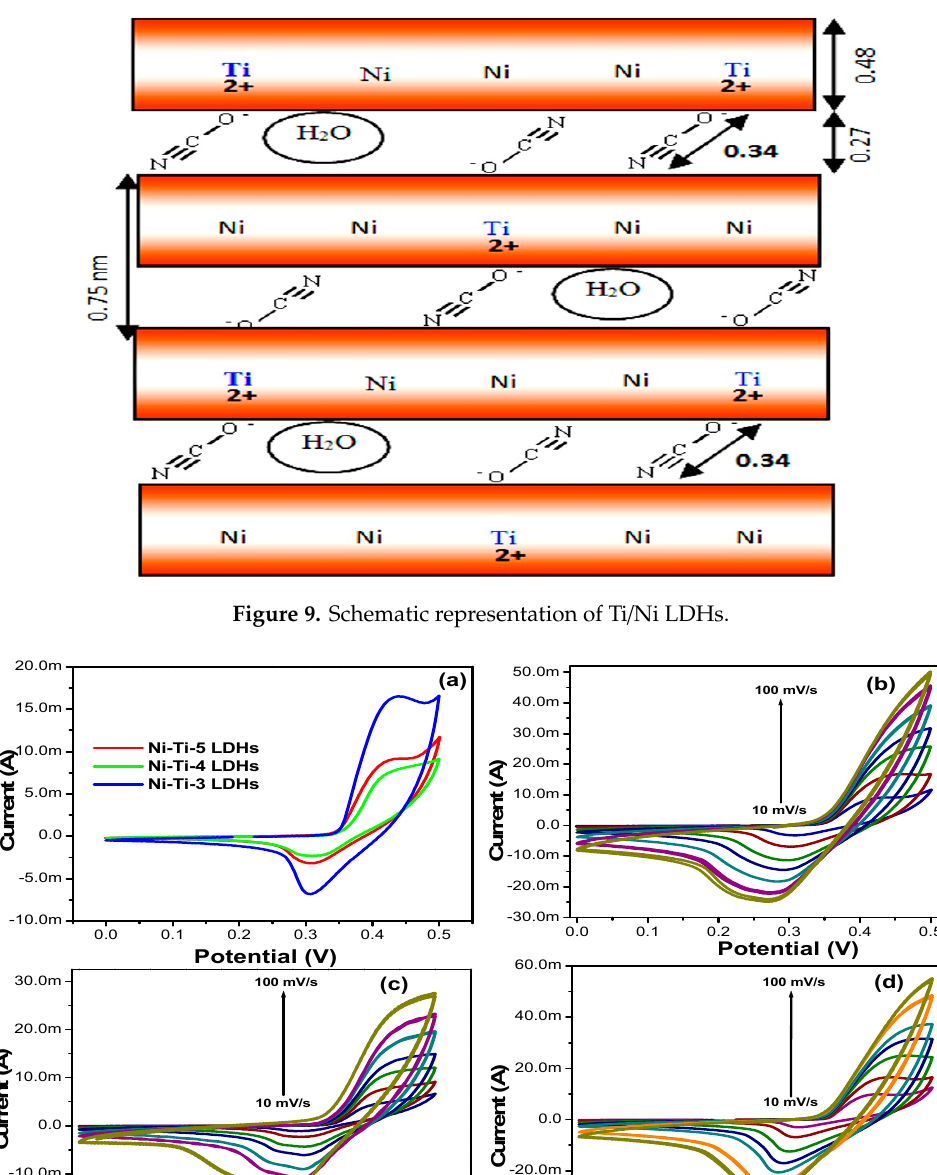
Figure 8. SEM images of ( a ) Ni-Ti-5 LDHs and ( b ) Ni-Ti-3 LDHs